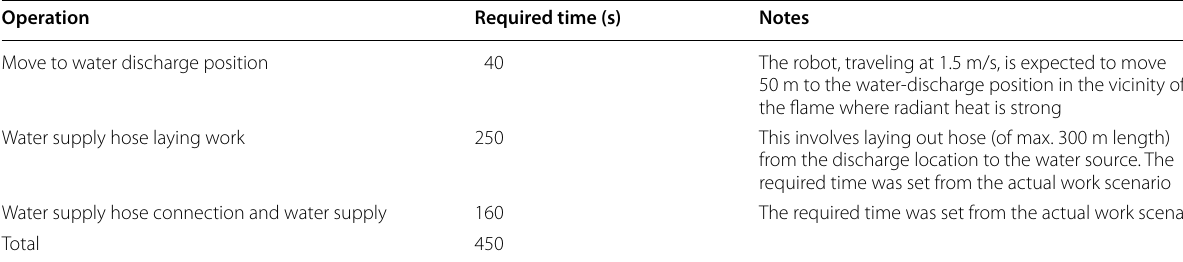
Table 8 Time estimation table for water cannon robot requiring cooling spray